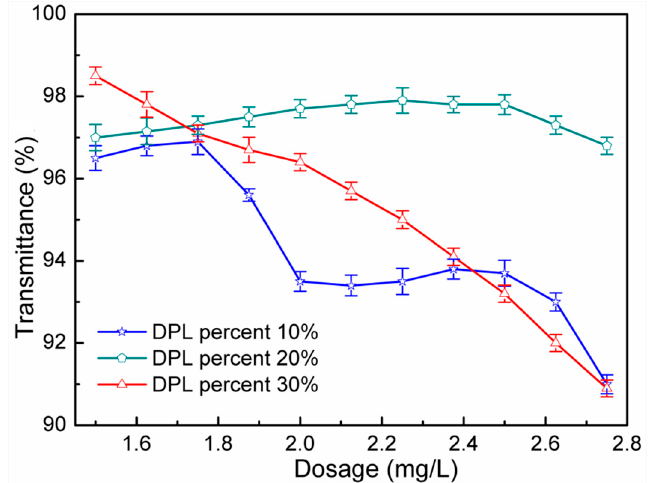
Figure 4. Effect of DPL dosage on transmittance.